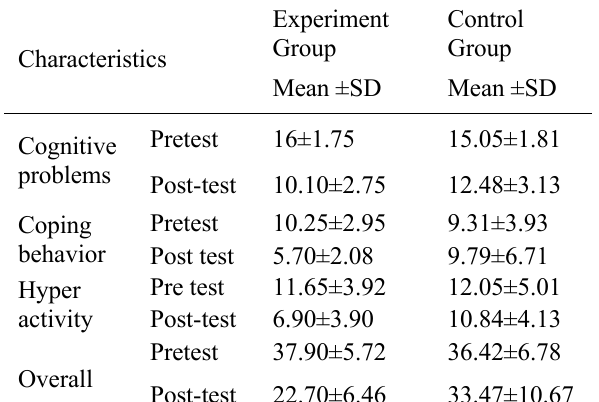
Table 2. The mean and standard deviation of Attention Def- icit Hyperactivity Disorder components in pretest and post-